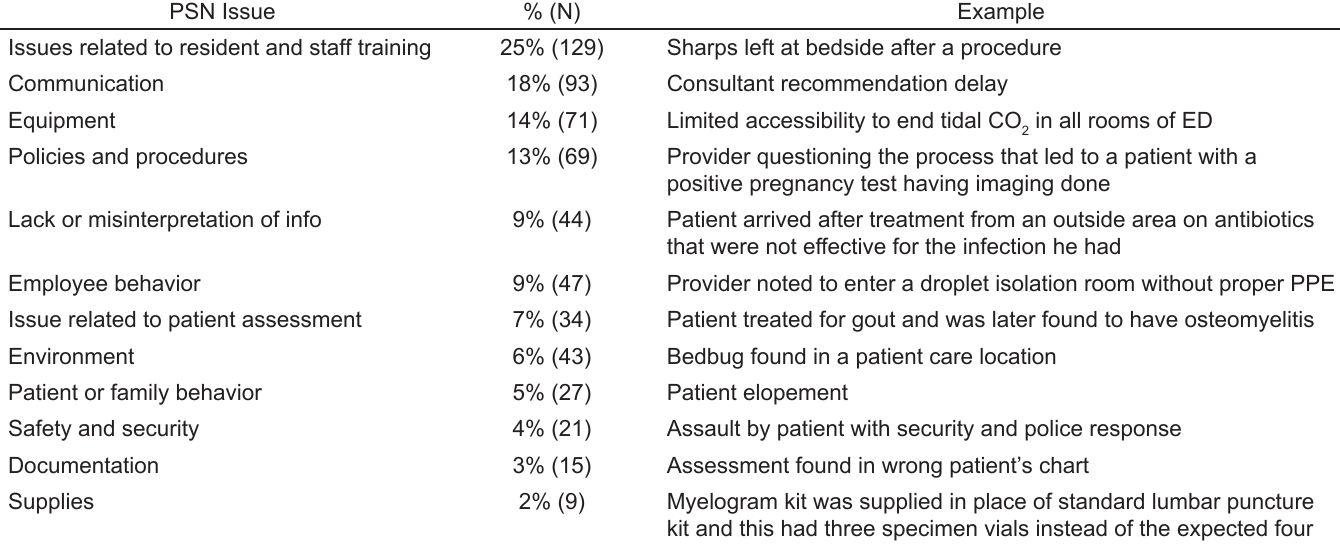
66 PSNs noted multiple issues: 2 with four issues, 11 with three issues, and 55 with two